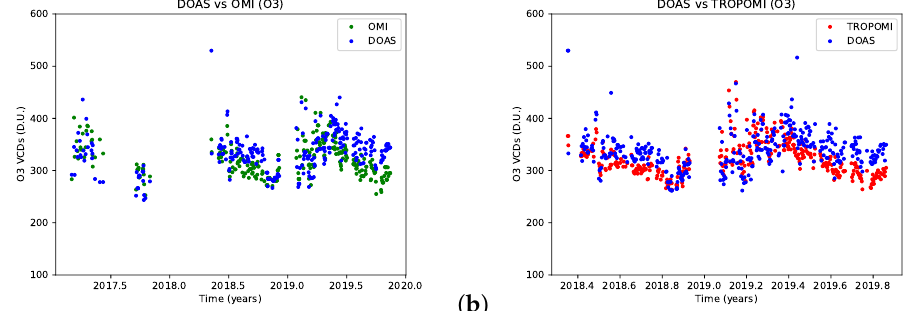
Figure 15. O 3 VCDs measured by GASCOD/NG4 (blue dots in both panels), OMI (green line in the panel ( a )) and TROPOMI (red line in the panel ( b )) over the ECO observatory. DOAS measurements are time averages in a 3-h time bin around satellite overpass, abd satellite data are the averages of all the coincidences within a 20 km radius.